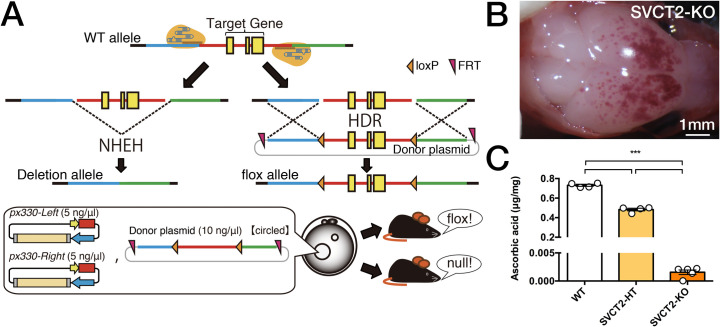
Strategy used for generation of Slc23a2-KO mice by a modified CRISPR/Cas9 gene editing system.A. Method used to generate Slc23a2-floxed and Slc23a2-null mice using the CRISPR/Cas9 system. B. Gross examination of the surface of the brain after removal of the cranial bones. The Slc23a2 homozygous null (SVCT2-KO) showed petechiae and ecchymoses over cerebral convexity. Scale bars, 1 mm. C. Whole brain ASC levels measured by HPLC with chemical detection. For comparison, the ASC content in Slc23a2 heterozygous null (knockout) (SVCT2-HT) brains is shown. Data are presented as the mean ± SE, n = 4–5 foetuses per group. The groups were all different at P<0.001 as indicated (***).